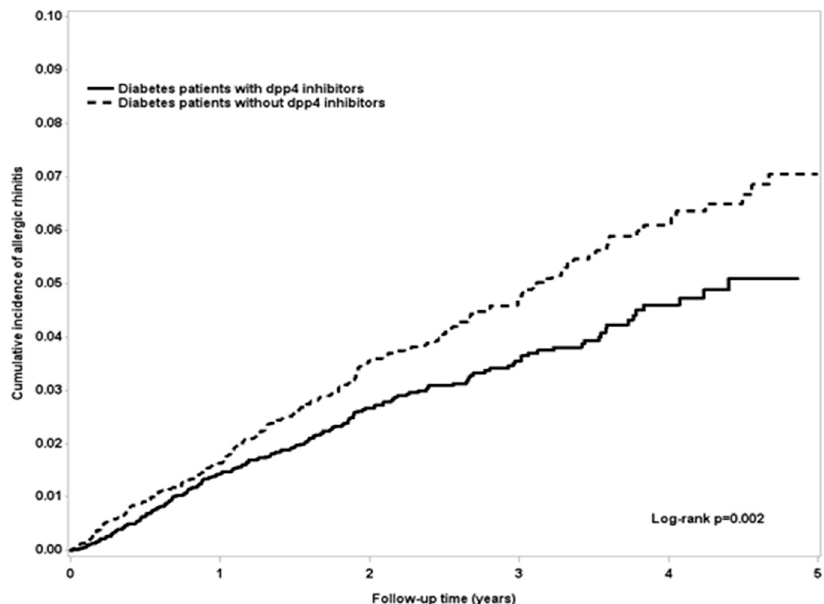
Figure 1. The incidence rates of allergic rhinitis (AR) for DPP-4 inhibitor users and nonusers were 1.24 and 1.66 per 100 person-years, respectively. DPP-4 inhibitor users exhibited a reduced risk of AR (aHR = 0.74, 95% confidence interval (CI) = 0.61–0.90), and DPP-4 users had a lower incidence of AR. Table 2. Incidence rate and hazard ratio of allergic rhinitis in diabetes patients of DPP-4 inhibitor users compared to non-users.